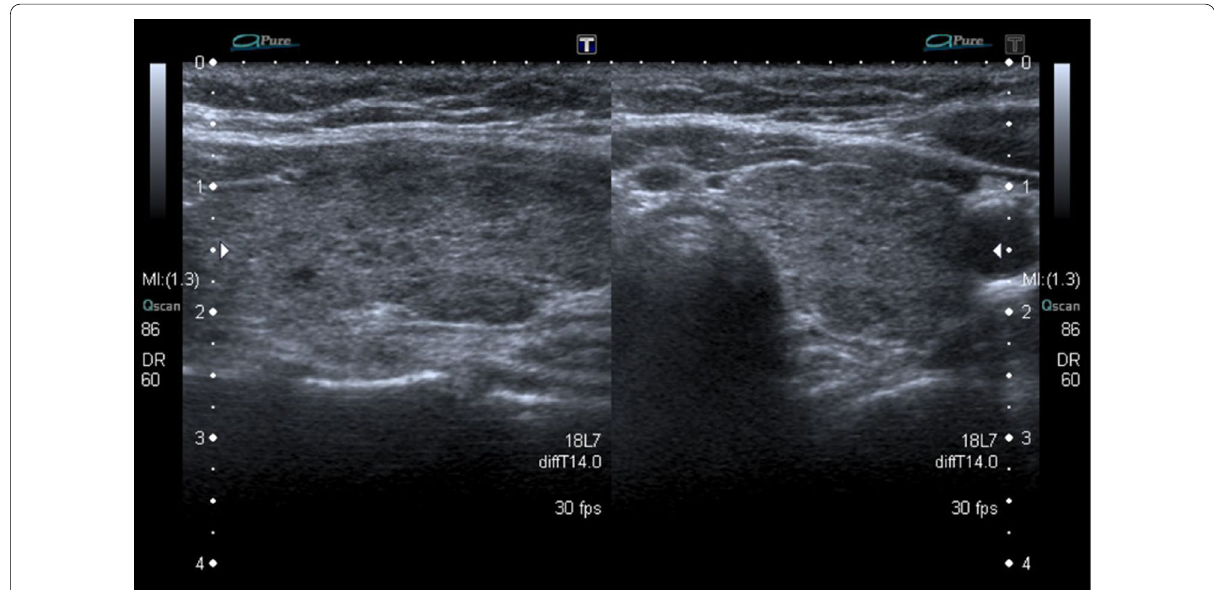
Fig. 1 Female euthyroid patient, 23-years old. Right thyroid lobe longitudinal (right) and transverse (left) views gray-scale U/S shows parenchymal echogenicity grade 1with undulation of the gland surface